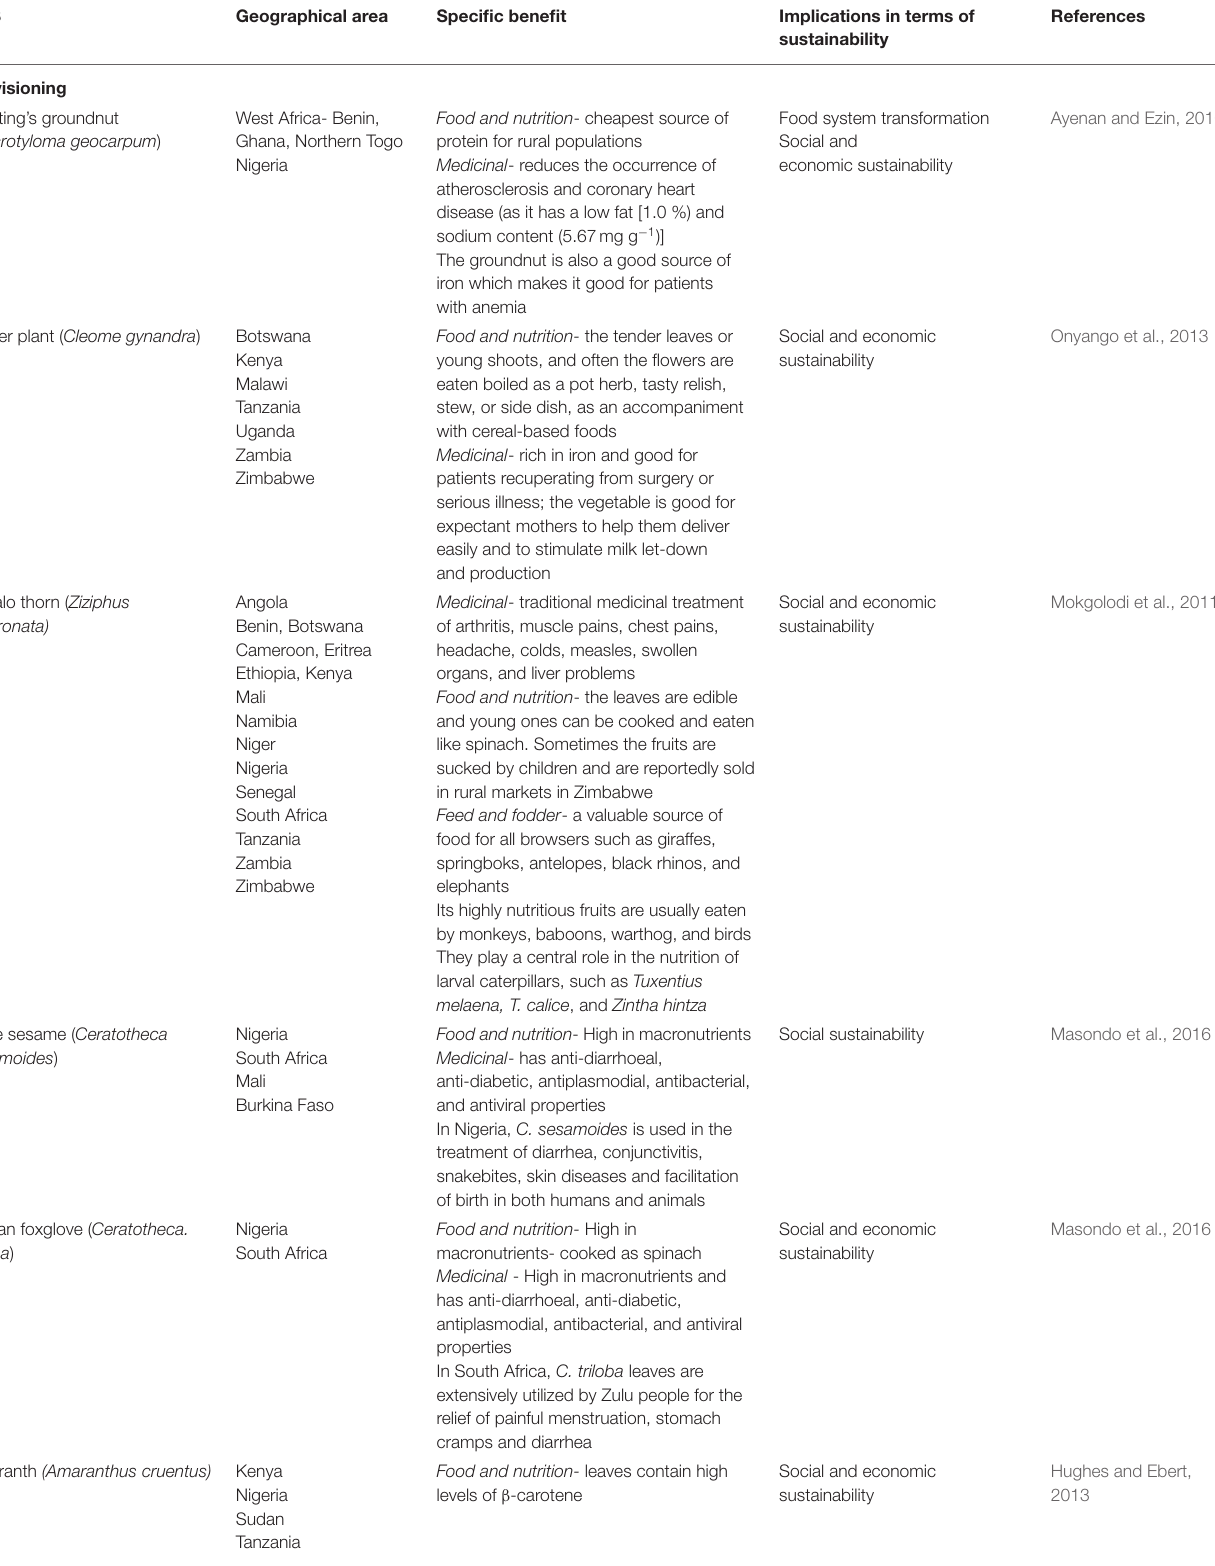
TABLE 1 | The contribution of selected NUS in Africa to the four ecosystem service areas.